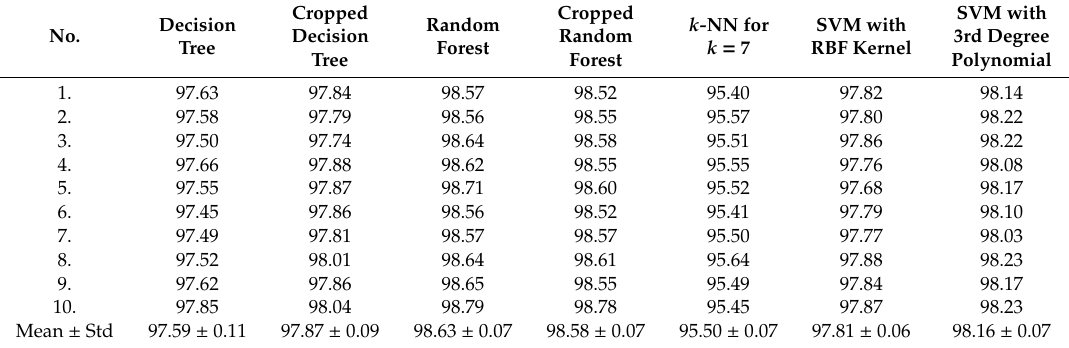
Table 1. Results of 10-fold cross-validation training—classification accuracy for the classifiers trained on the parametrized data consisting of 42 parameters (training procedure SP).